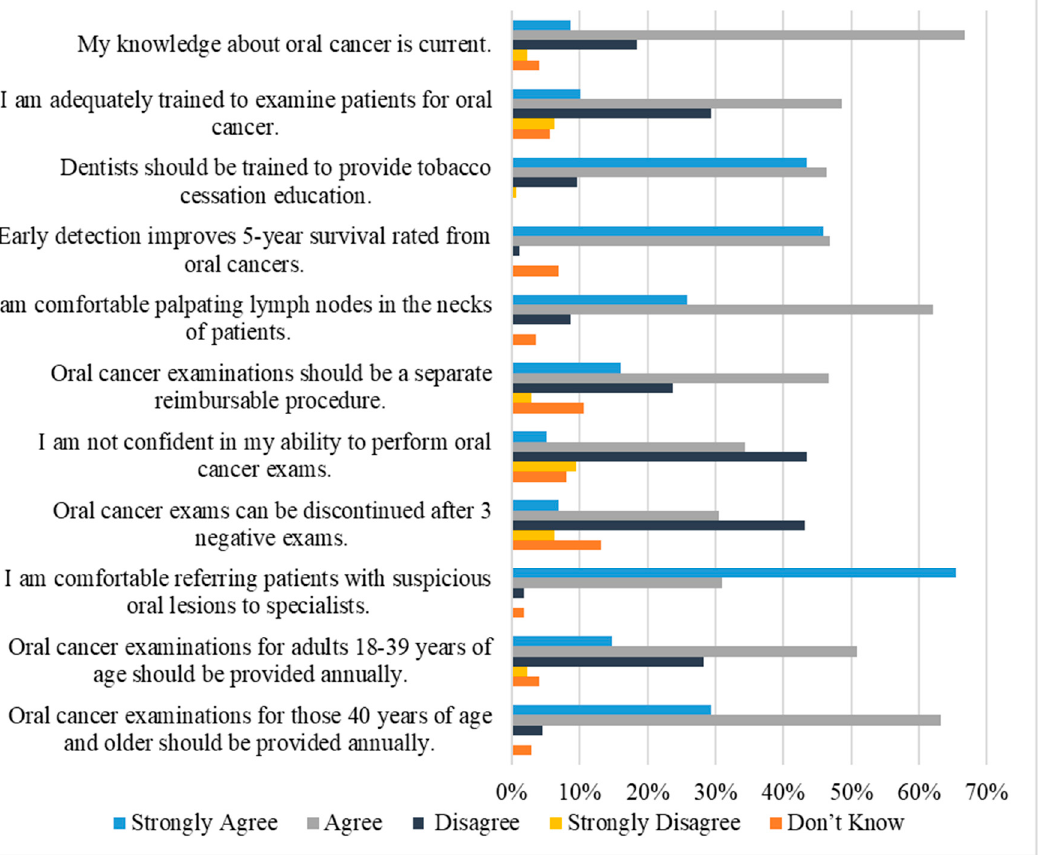
Figure 4. Dentists’ attitudes toward oral cancer examination ( n = 177).